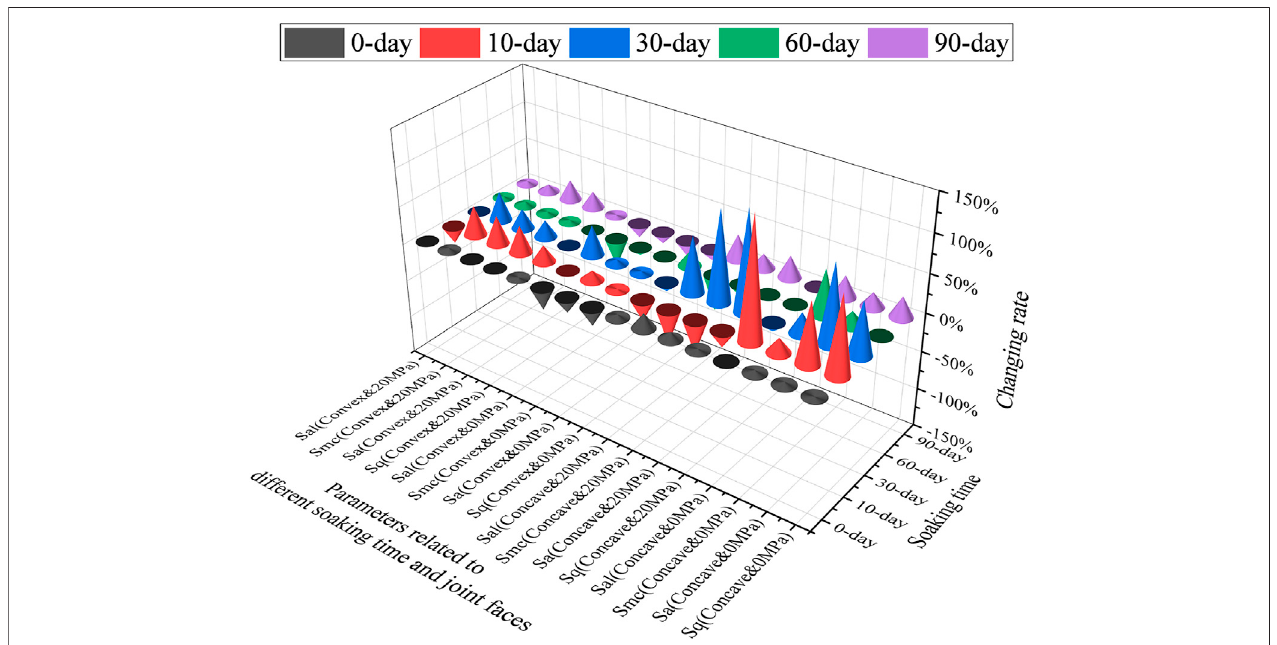
FIGURE 4 | The change rate of joint surface morphology parameters under different immersion time and fracture water pressure conditions.